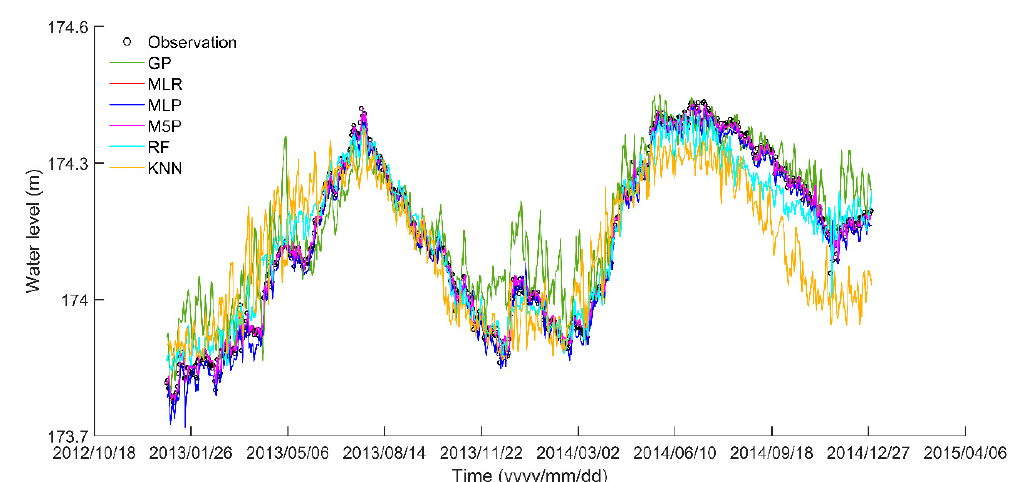
Figure 4. Time series of predicted and observed water level of Lake Erie during the testing period from January 1st 2013 to December 31st 2014.